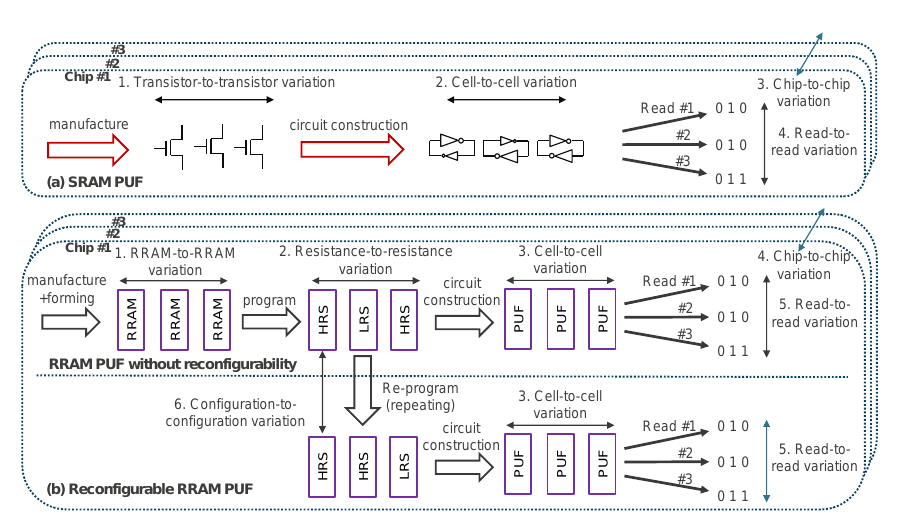
Figure 1: The operation flow and different types of variation on (a) conventional SRAM PUF and (b) reconfigurable RRAM